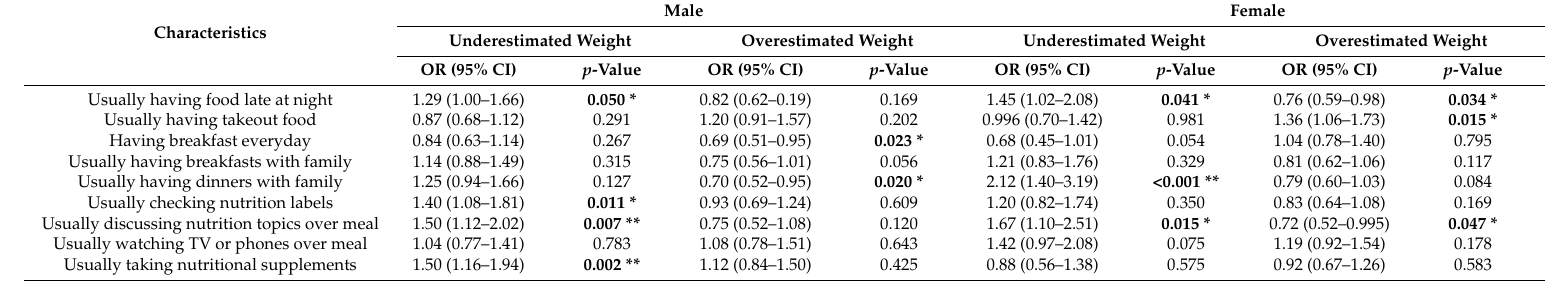
Table 6. Association between eating behaviors and weight status misperception among male and female respondents (Logistic regressions, N = 2641).